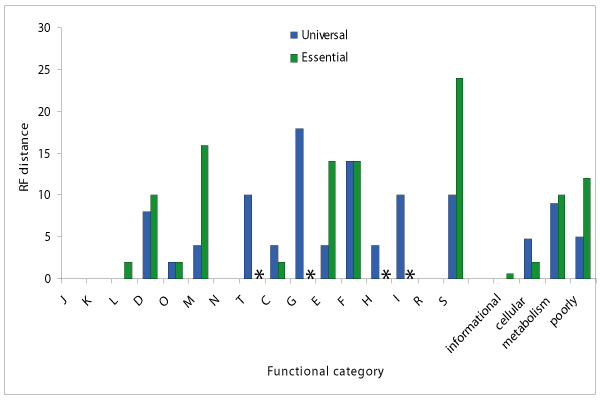
Reference Tree (RT) and taxonomical classification of the 21 Proteobacteria genomes studied. The figure is adapted from a previous work (Comas et al. submitted). The taxa and their corresponding taxonomic classification are shown. The topology was obtained in an extensive phylogenomic analysis with the same data set used here. The analyses included a 200-gene supermatrix, a 579-gene supermatrix with coding for absent genes and the supertree derived from the phylome of Blochmannia floridanus. Further analyses aimed to correct for the possible influence of GC content bias affecting mainly endosymbiont genomes resulted in the same topology shown here. The branch lengths provided were retrieved from a concatenation of 60 informational genes analyzed by maximum likelihood.